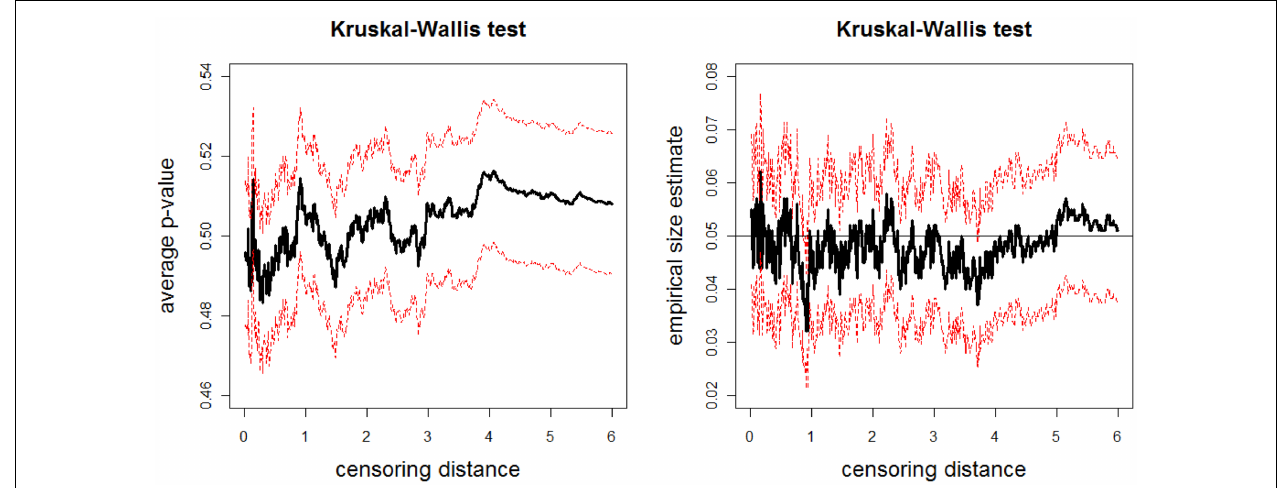
FIGURE 7 | Plotted in the left is the average p -values (solid line) and in the right is the empirical size estimates (solid line) versus censoring distance values for multi-group K–W test together with the 95% confidence bands (dashed lines) based on 1000 Monte Carlo replications under the null hypothesis in expression Eq. 11 which implies distributional equality of censored X , Y , and Z values . Horizontal line in the right plot is at 0.05.